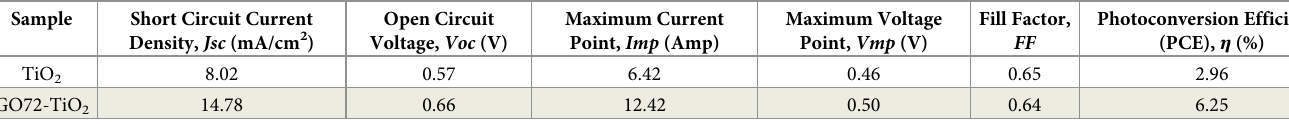
Table 5. Typical photovoltaic performance of DSSCs based on mesoporous TiO 2 and TiO 2 decorated with GO72. Sample Short Circuit Current Density, Jsc (mA/cm 2 )